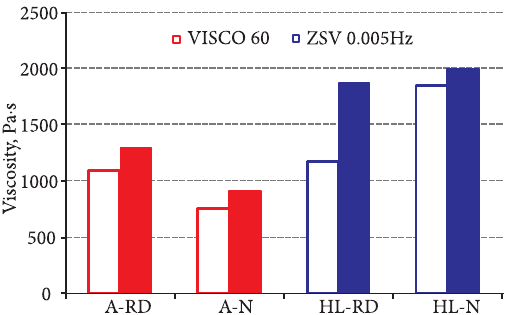
Fig. 4. Zero shear viscosity (ZSV) of extracted binder at temperature of 60 °C at frequency f = 0.005 Hz in comparison with dynamic viscosity at 60 °C (VISCO 60) Table 2. The evaluation of the influence of the qualitative factors on the dynamic viscosity (VISCO60) at 60 °C